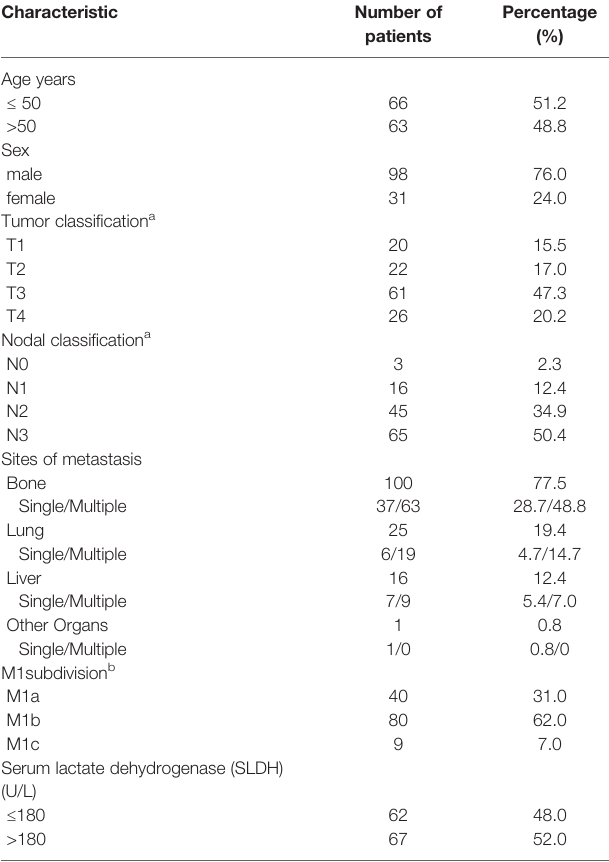
TABLE 1 | Clinical characteristics.